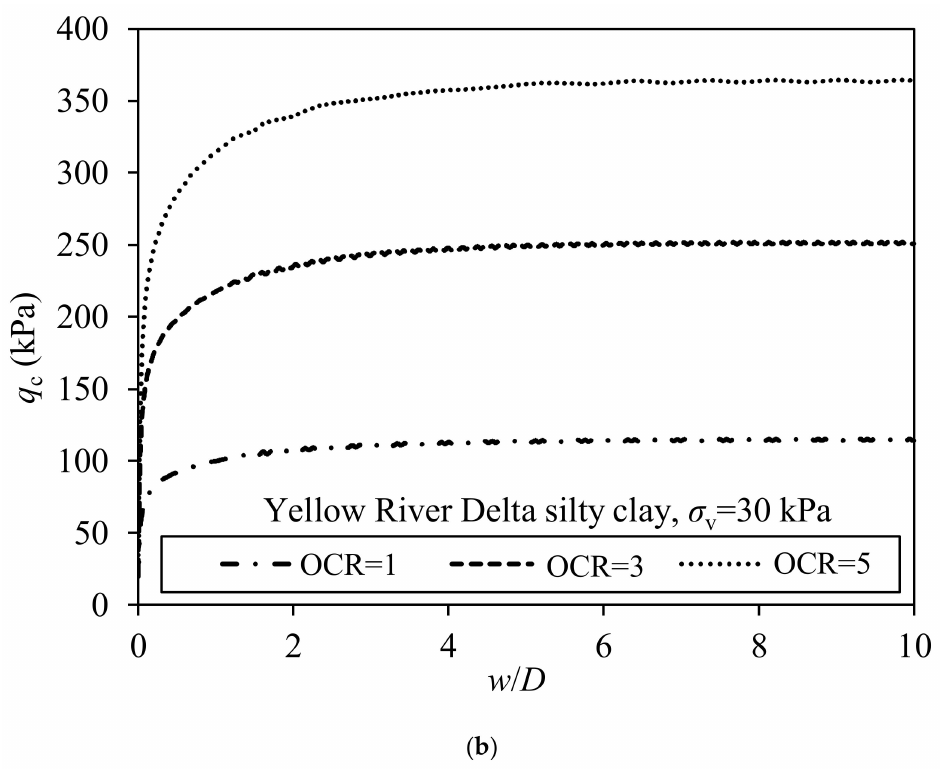
Figure 3. Penetration resistance under different OCR at σ v = 30 kPa. ( a ) Kaolin silty clay; ( b ) Yellow River Delta silty